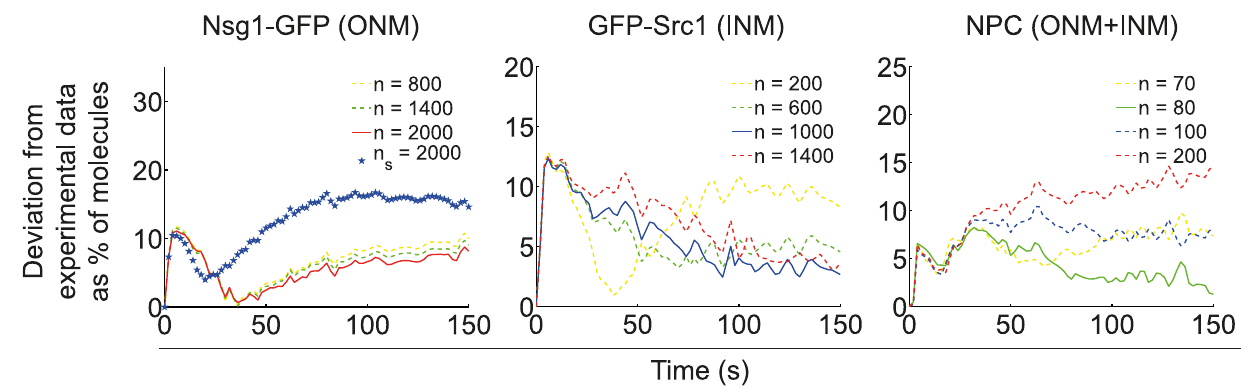
Figure 6. Estimated number n of proteins at the ring constraining lateral diffusion in EA nuclei. Average deviations (in percentages) of stochastic simulations from the experimental mean for each experimental time step. Mother and daughter lobe deviations are calculated as the absolute value of the difference between simulations and FLIP experiments. The average deviation is the mean of both nuclear lobes’ deviations over time. The best fit (i.e. minimal deviation) is shown as a continuous line. For NPC data, we assumed the specialised lipid domain lies at both the ONM and INM, whereas the protein ring is present at the ONM only. Effective diffusion coefficients were fixed as in Table S2 and we fixed P out =100% in all cases. P in values were fixed as in the homogeneous domain scenario in LA (Table 1). For Nsg1-GFP, n s stands for the number of septin proteins in a double ring